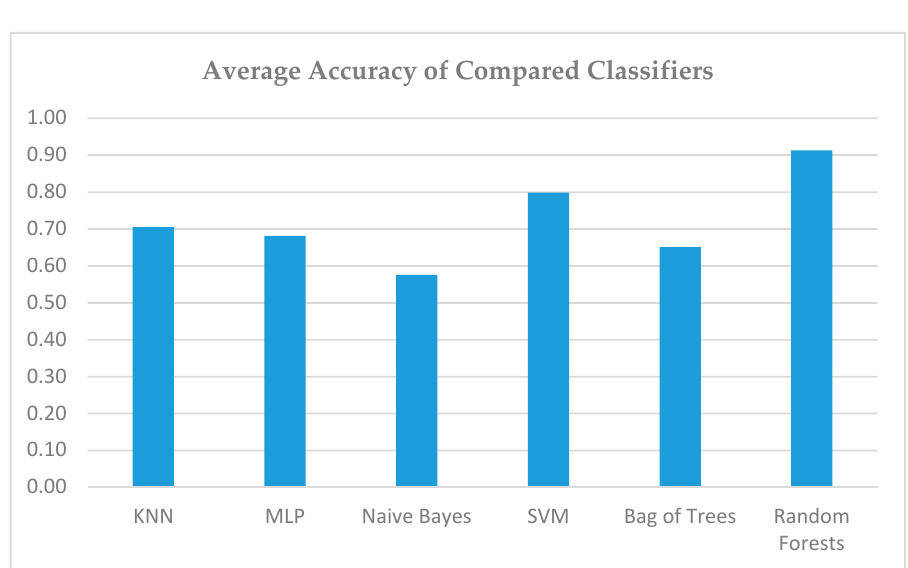
Figure 10. Comparison of Accuracy of all Classifiers.